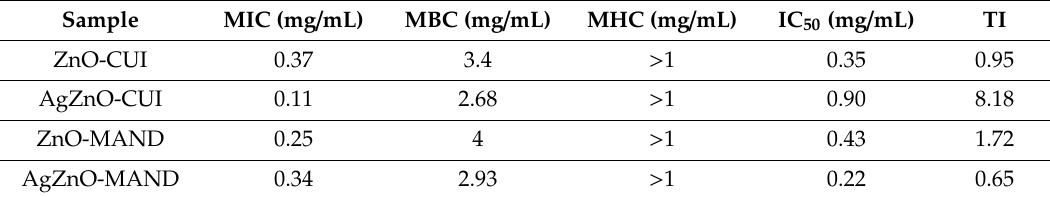
Table 1. Bacteriostatic (MIC) and bactericidal (MBC) action against S. aureus ; the half viability concentration (IC 50 ) on BJ cells, minimal hemolytic concentration (MHC) and calculated TI for tested